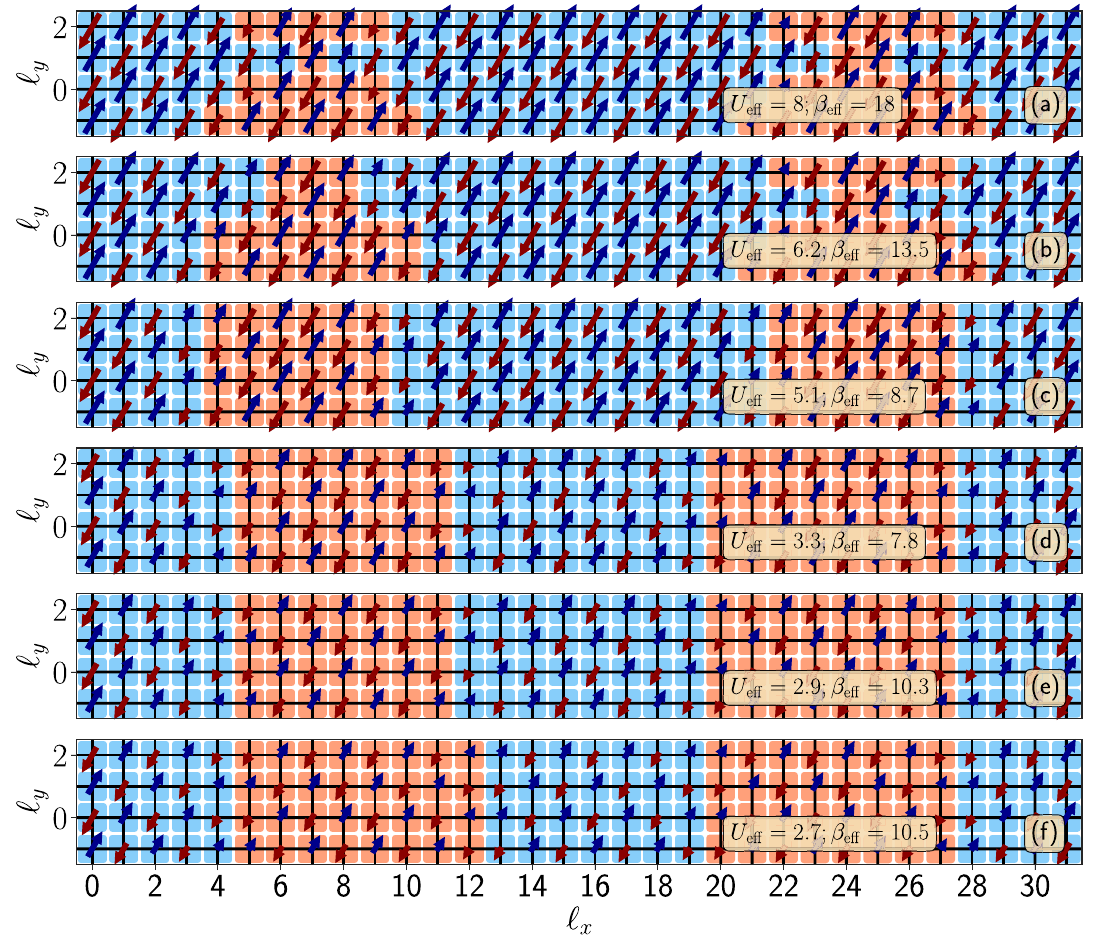
FIG. 6. (a) – (f) Convergence of the trial state in the self-consistent process which couples it to the AFQMC calculation. The spin ; β density in real space is shown for the UHF solution at selected ð U values on the optimization path shown in Fig. 1. Each UHF eff eff Þ solution is used to form the input trial density matrix H T for the next step AFQMC calculation in the iteration. The trial state starts from an incorrect diagonal stripe order and converges to the correct order from the self-consistent coupling to AFQMC. The system is 32 × 4 with δ ¼ 1 = 8 and the amplitude of edge pinning fields is v ¼ 0 . 1